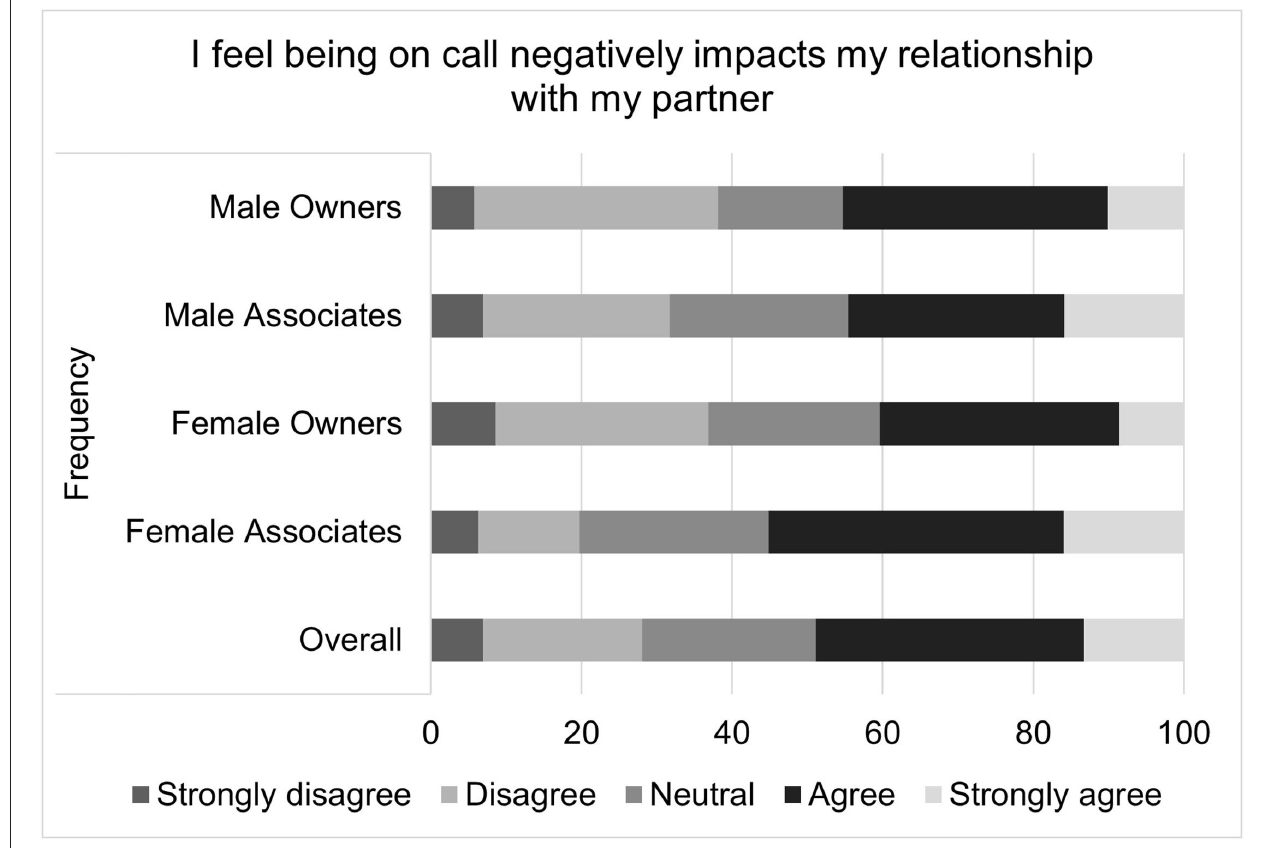
FIGURE 7 | Perceived negative effects of on-call duties on psychological health, as reported by male and female practice owners and associate veterinarians.